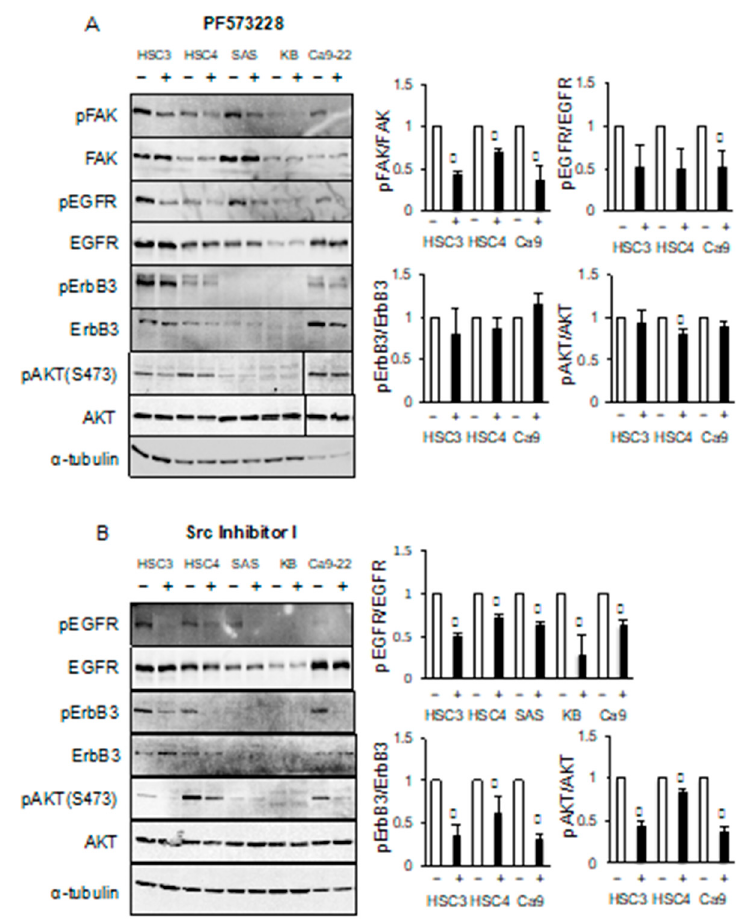
Figure 7. Src inhibitor reduces the phosphorylation levels of EGFR, ErbB3, and AKT. HSC3, HSC4, SAS, KB and Ca9-22 cells were treated ( A ) with or without PF573228 or ( B ) Src inhibitor-1. The levels of phosphorylated FAK (pFAK), FAK, phosphorylated EGFR (pEGFR), EGFR, phosphorylated ErbB3 (pErbB3), ErbB3, phosphorylated AKT (pAKT), and AKT were determined by western blotting analysis. α -tubulin was used as the loading control. * Significantly different from control, p < 0.05. Experiments were performed at least three times independently.